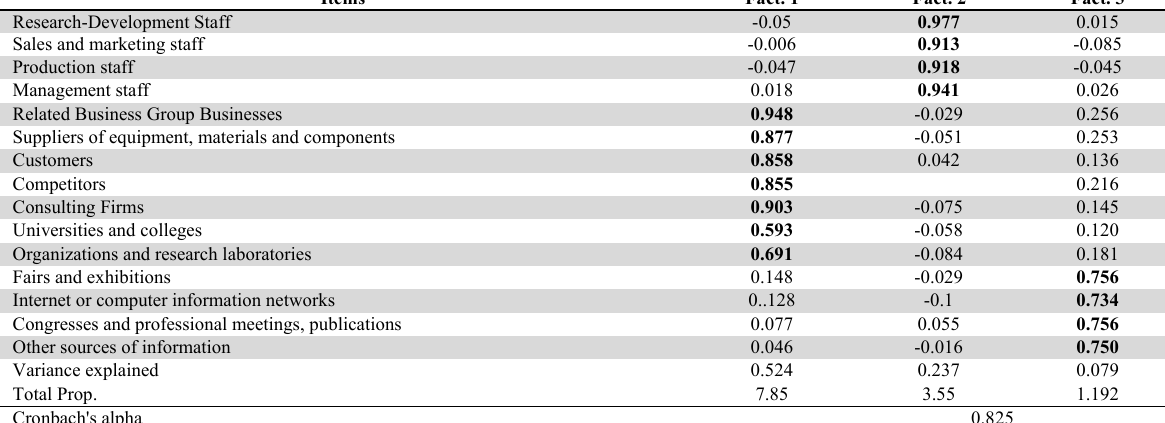
Principal component analysis of the variable relating to information Sources: Factor weights (Varimax Normalized) Items Fact.